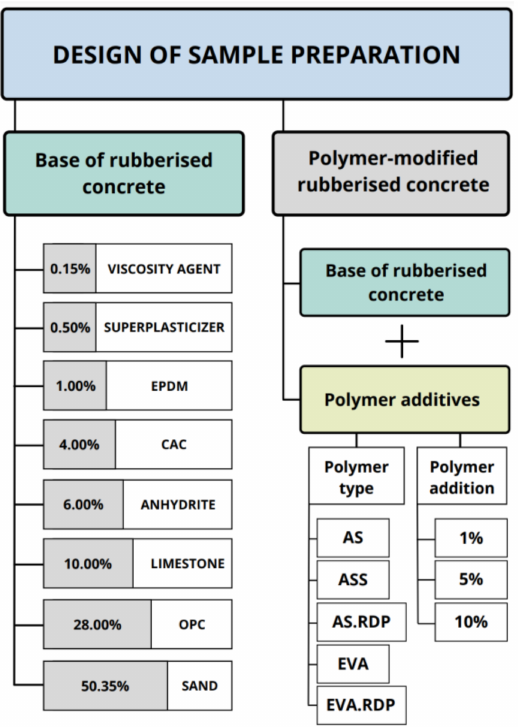
Figure 1. Composition of the obtained